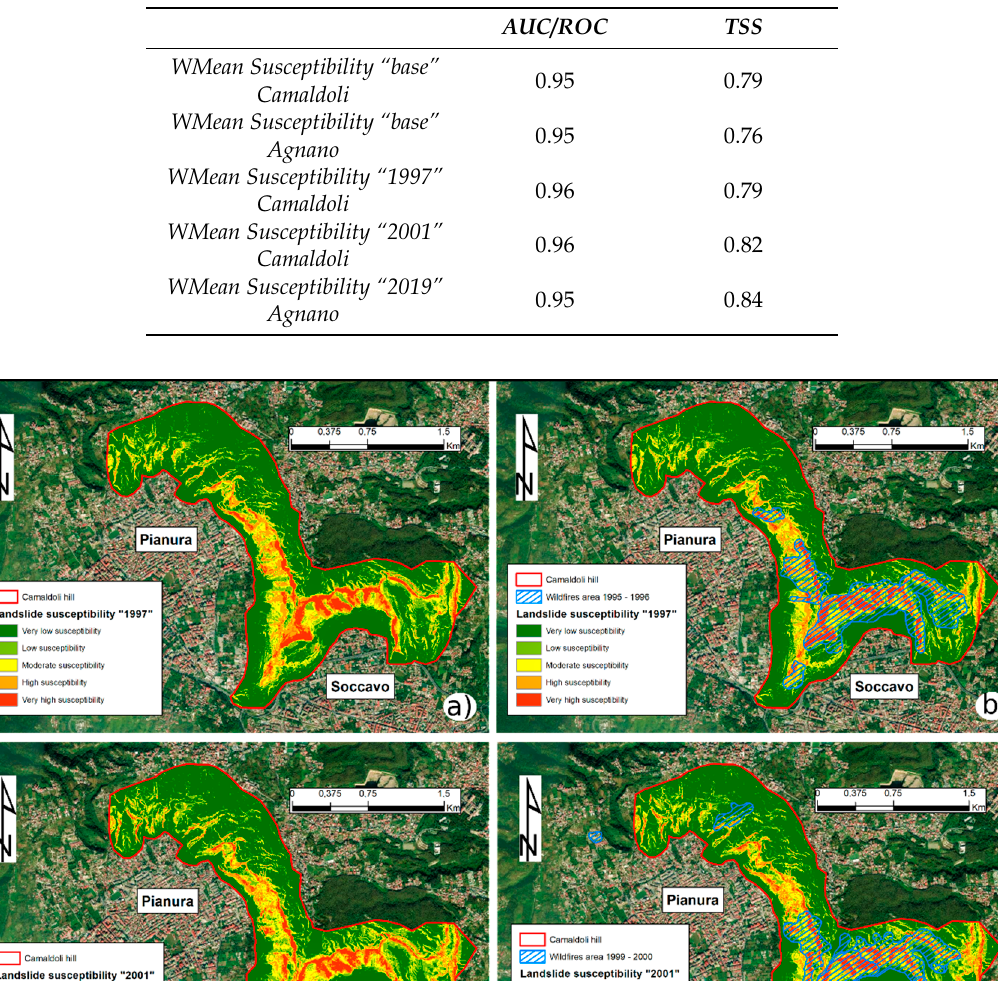
Table 6. AUC/ROC and TSS scores for the ensemble models Table 6. AUC / ROC and TSS scores for the ensemble models used.